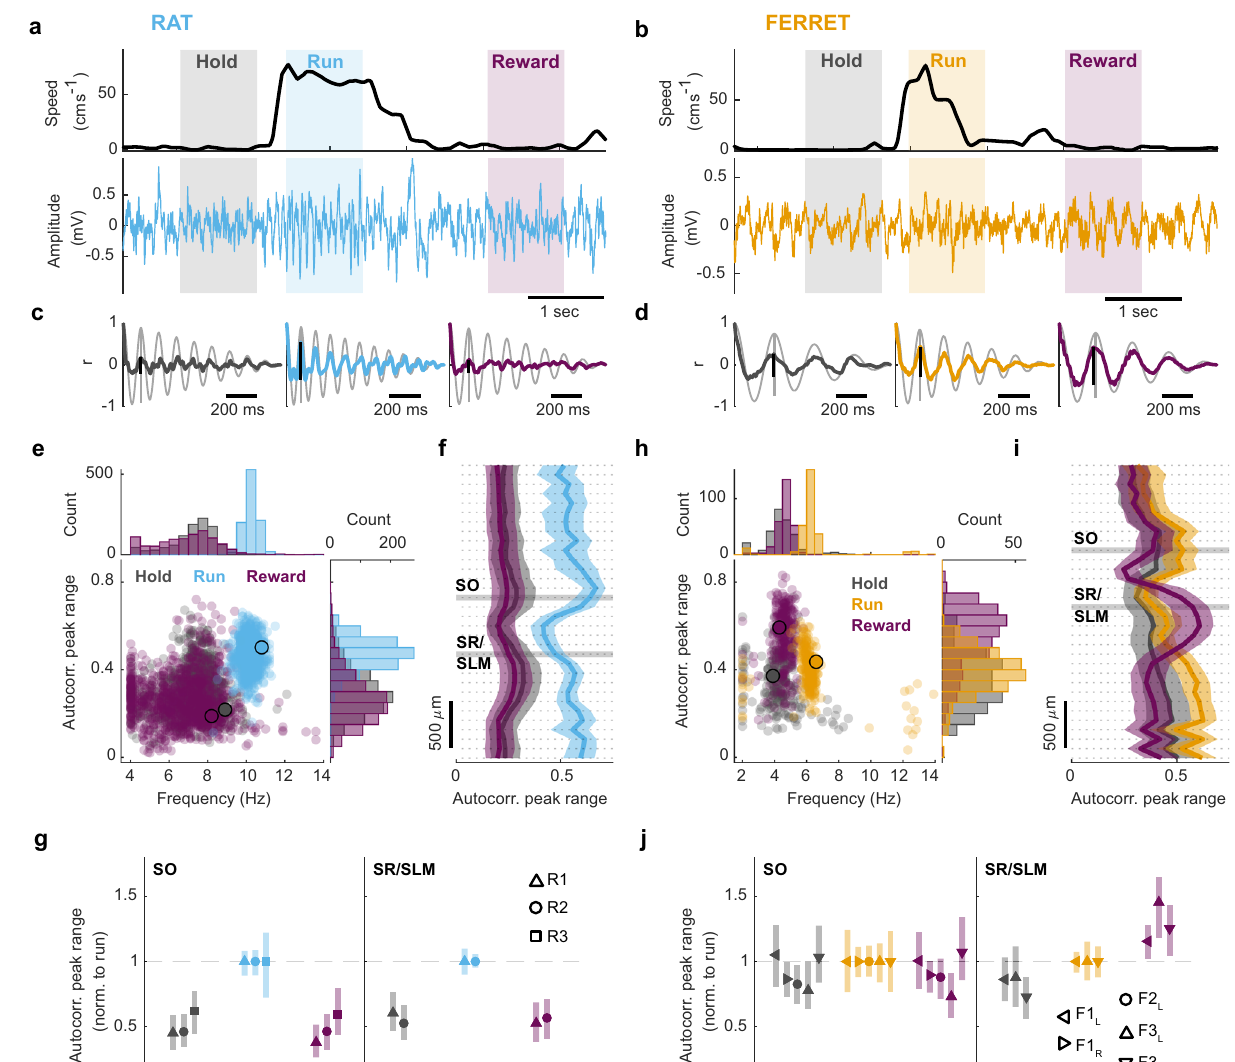
Fig. 6 | Type 2 theta in the ferret is modulated by behavioural state. Example trialsfrom a ratR1and b ferretF3 L .Top:HeadspeedacrossexampletrialswithHold (grey shading), Run (rat: blue shading; ferret: orange shading) and Reward (purple shading) epochs highlighted. Bottom: Corresponding neural trace (rat: 2Hz high- pass fi ltered, 50Hz notch fi ltered; ferret: 1Hz high-pass fi ltered, 50Hz notch fi l- tered) recorded from the stratum radiatum/stratum lacunosum moleculare (SR/ SLM). c , d AutocorrelogramsofLFPsegmentsduringthetrialepochshighlightedin a , b: Hold (grey, left plot), Run (blue/orange, middle plot), Reward (purple, right plot); overlaid on the matched sinusoid wave autocorrelation (light grey lines). Black vertical lines illustrate the uncorrected peak range measurement for each epoch, vertical grey line indicates peak range of matched sinusoid used for nor- malisation. e Scatter plot and marginal histograms showing relationship between LFP trial epoch frequency and normalised autocorrelation peak range for Hold (grey), Run (blue) and Reward (purple) epochs in rat R1. Markers represent data